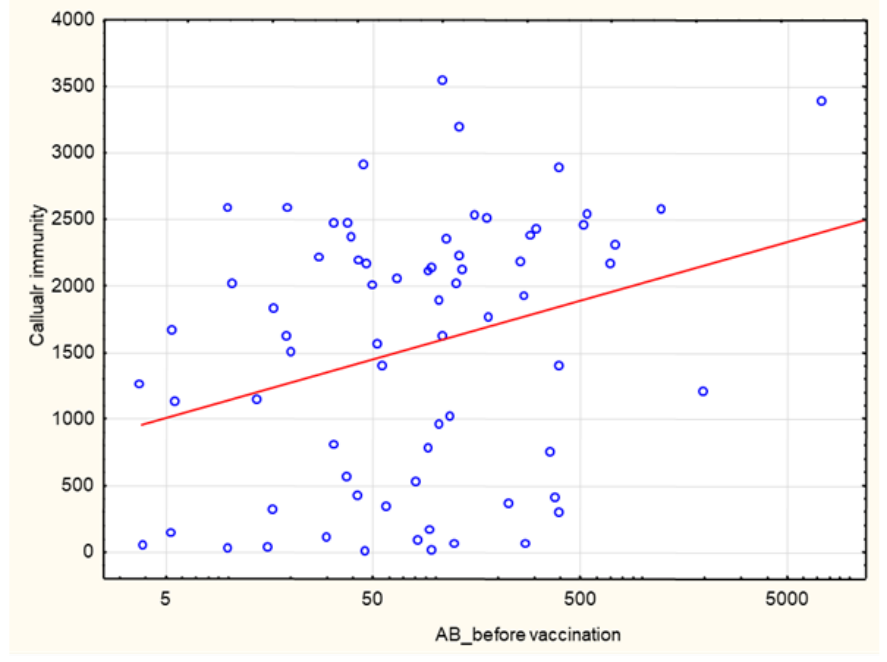
Figure 14. Positive correlation between pre-vaccination AB levels (AU/mL) and cellular immunity (INF γ concentration mIU/mL) at 1 month after the 2nd dose of SARS-CoV-2 vaccine ( p = 7.95 × 10 –09 , R 0.43). Spearman’s rank correlation test.